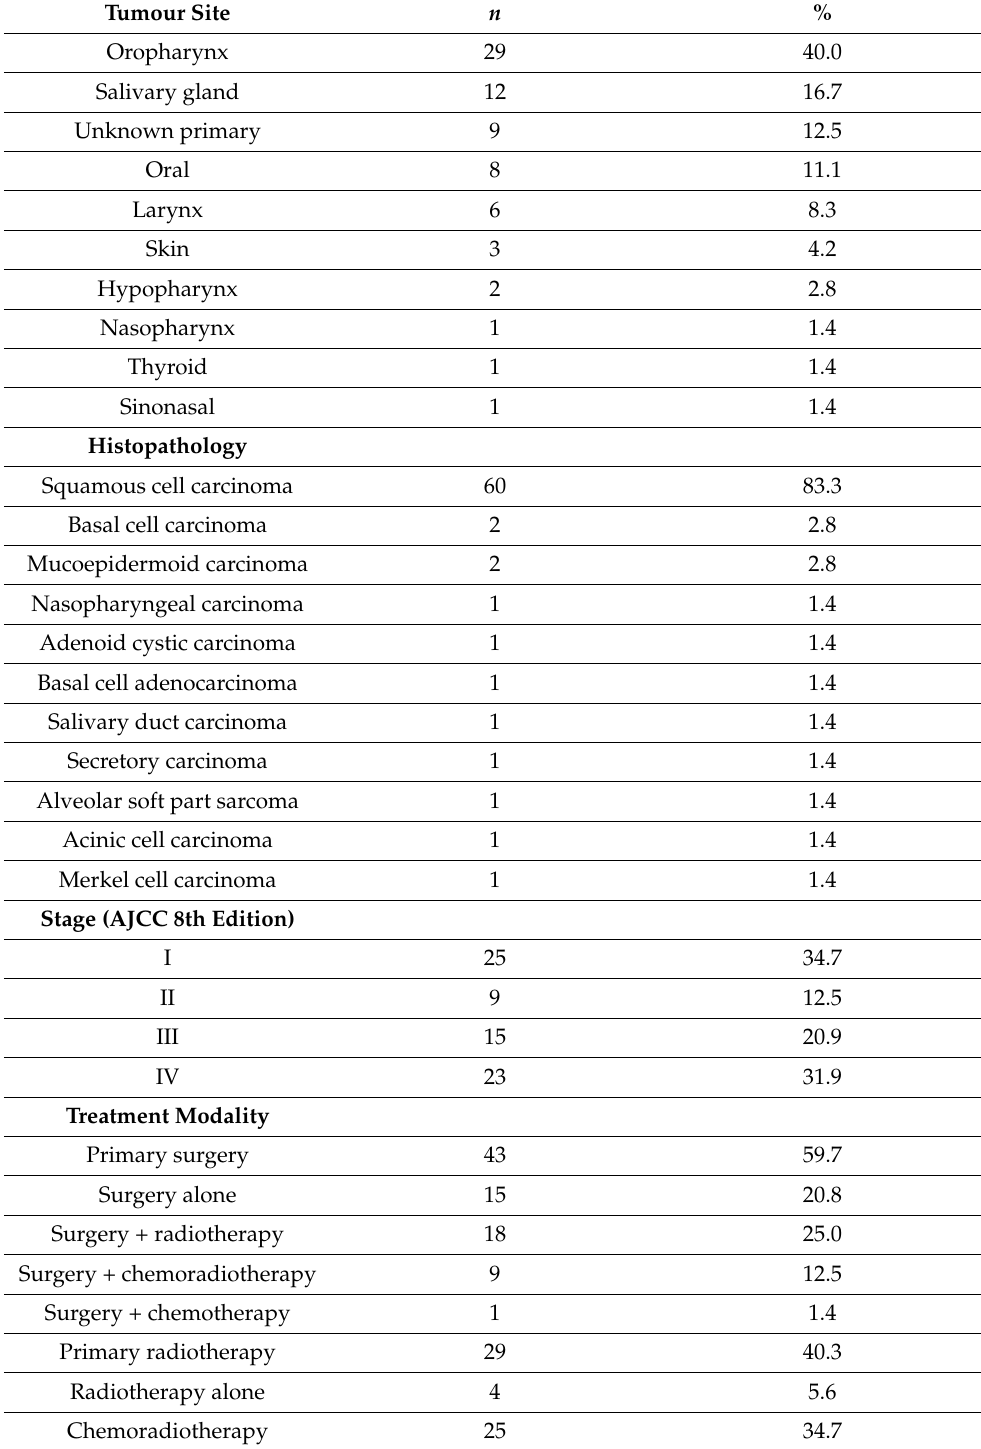
Table 1. Tumour characteristics and treatment